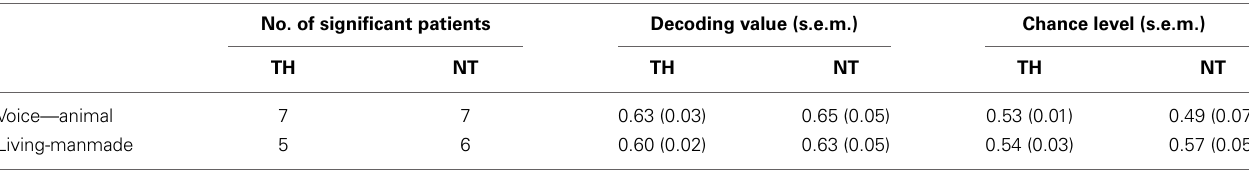
Table 1 | Summary of the decoding performance results for each of the categorical comparison, voice-animal and living-manmade and each recording during TH and